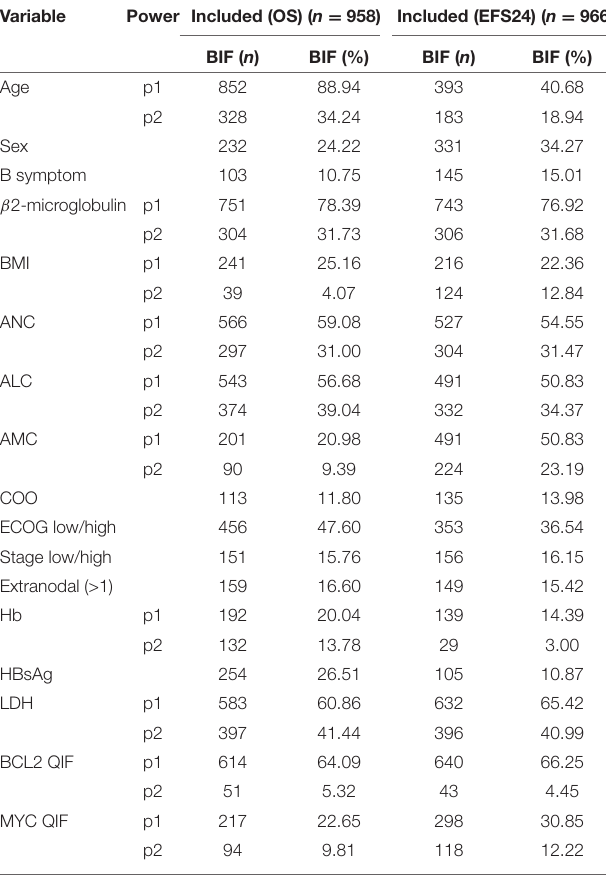
TABLE 2 | Summary of the MFP algorithm applied to the DLBCL patient data set. OS